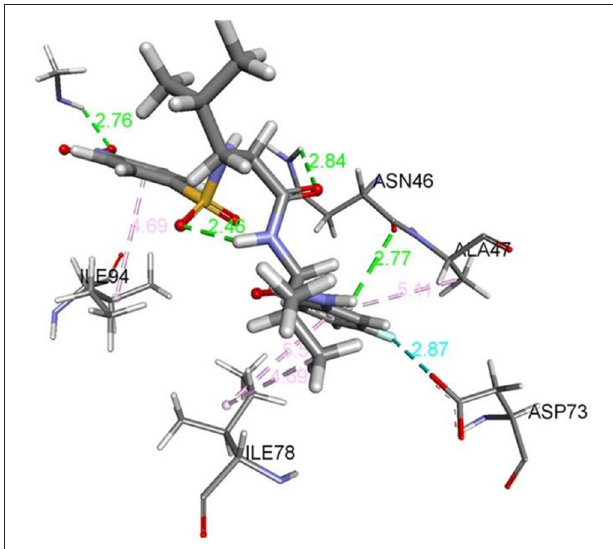
FIGURE 3 | The stereo view of compound 8d in the binding cavity of 5MMN.